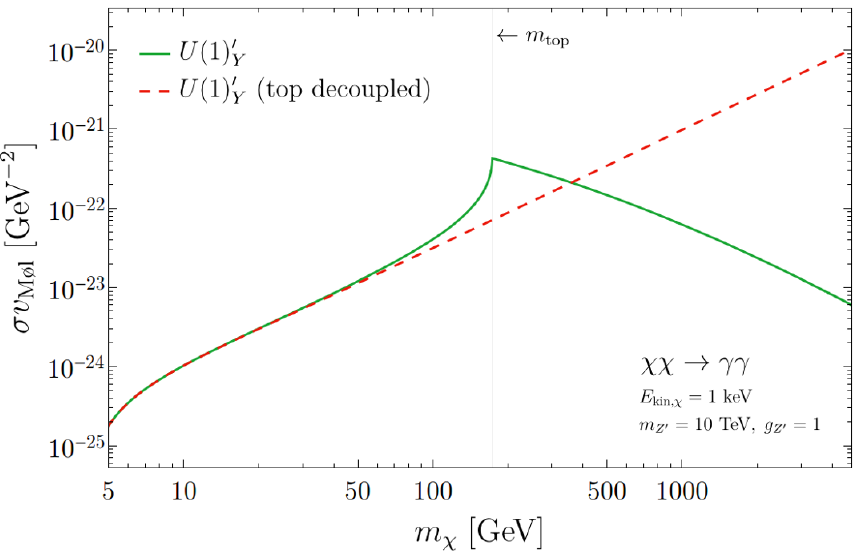
Figure 13 . The e(cid:11)ect of decoupling the top quark in a sequential hypercharge model. The green (solid) curve shows the cross section for DM annihilation to photons with m t = 175 GeV, while the red (dashed) curve shows the same cross section with an in(cid:12)nite top quark mass. In general, anomaly-induced e(cid:11)ects rise with energy until the mass scale where the anomaly is